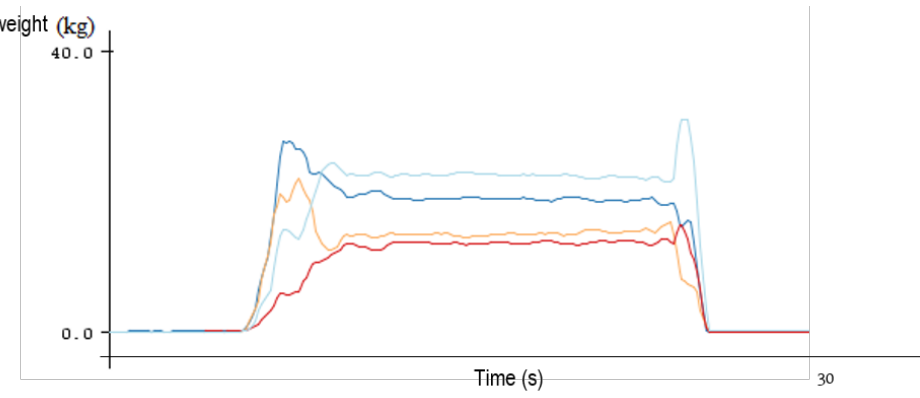
Figure 4. Plot of the raw load cell measures.